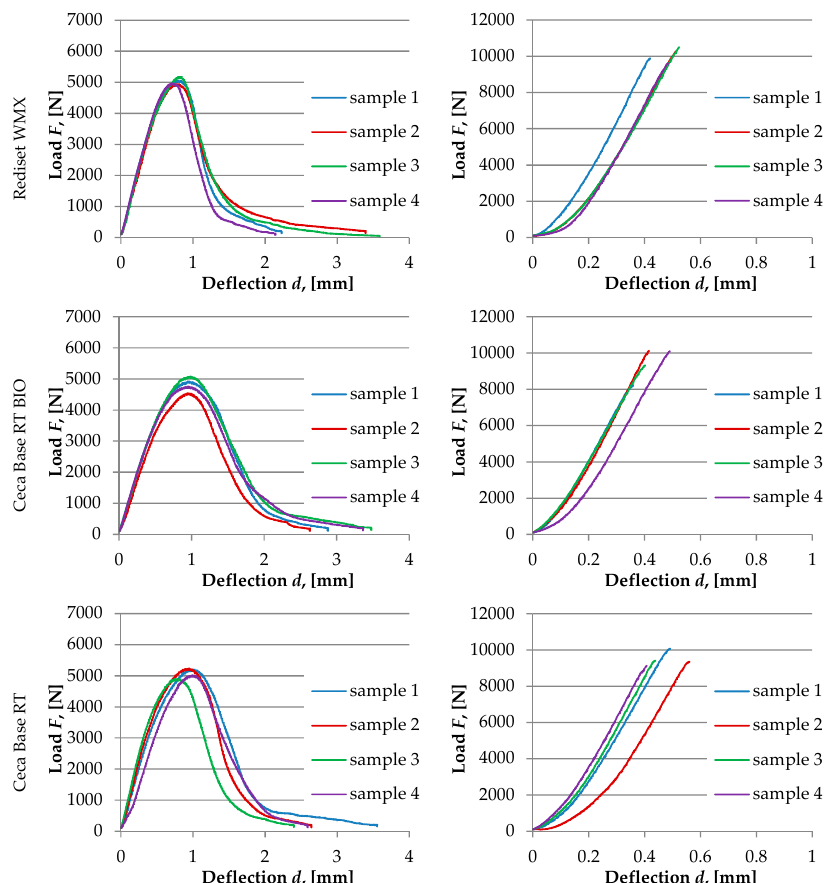
Figure 10. Selected results from the SCB test. Load/deflection curves for samples with a 10-mm notch. Left column: test temperature +10 °C. Right column: test temperature − 20 °C.